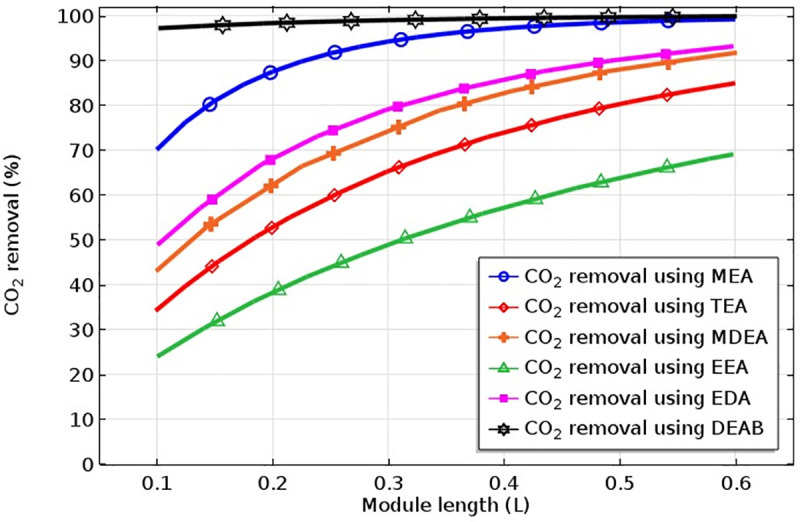
Impact of the module length parameter on the CO2 removal using MEA, TEA, EEA, EDA, MDEA and DEAB absorbents.